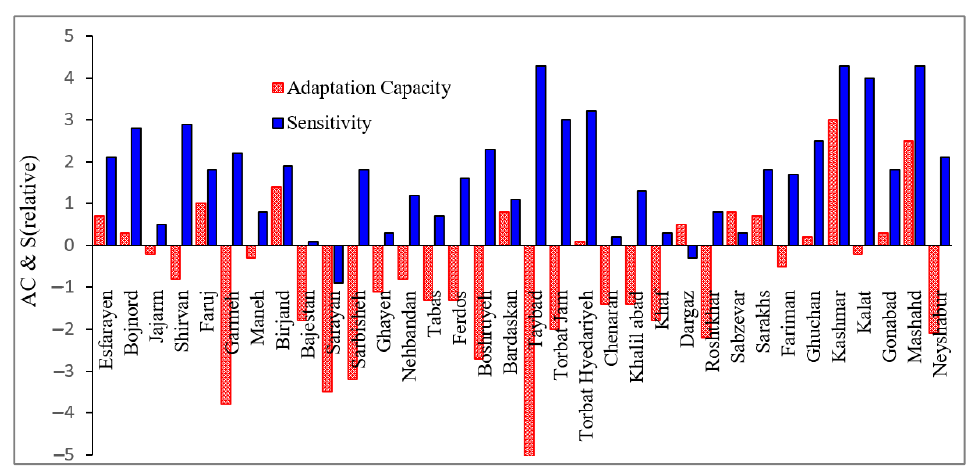
Figure 4. Amount of adaptation capacity and sensitivity of each county, using data retrieved from national MPO.